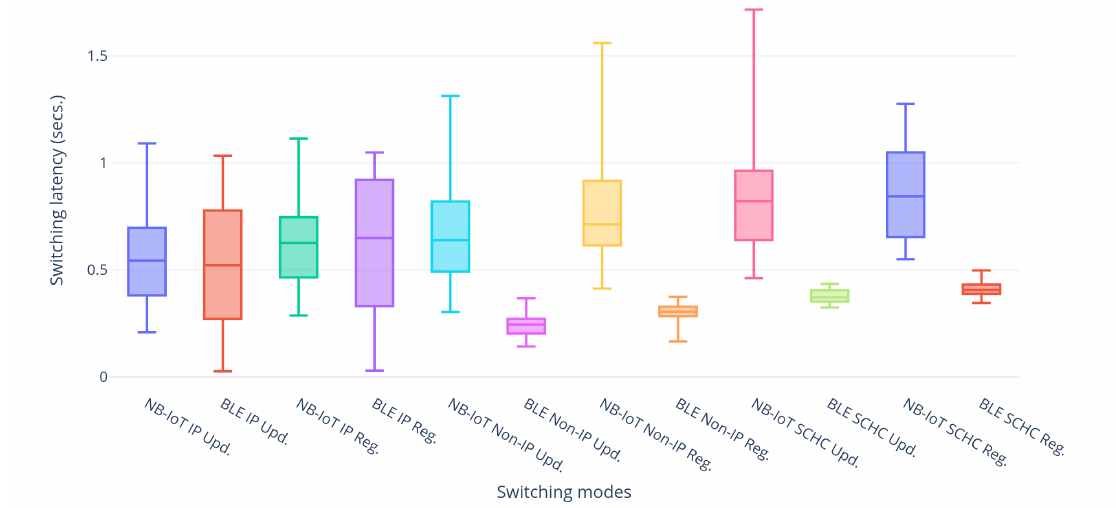
Figure 5. Handover latencies of Narrow Band IoT (NB-IoT) and Bluetooth Low Energy